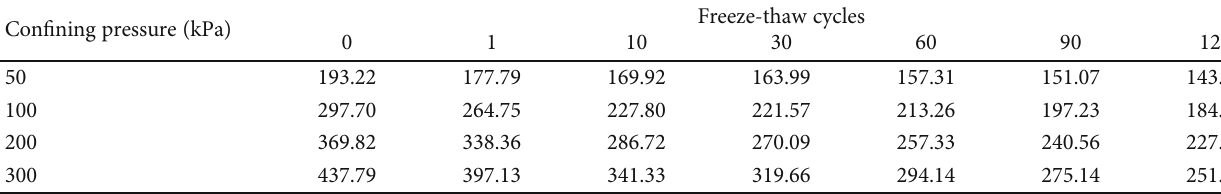
Table 4: Undrained shear strength of specimens.